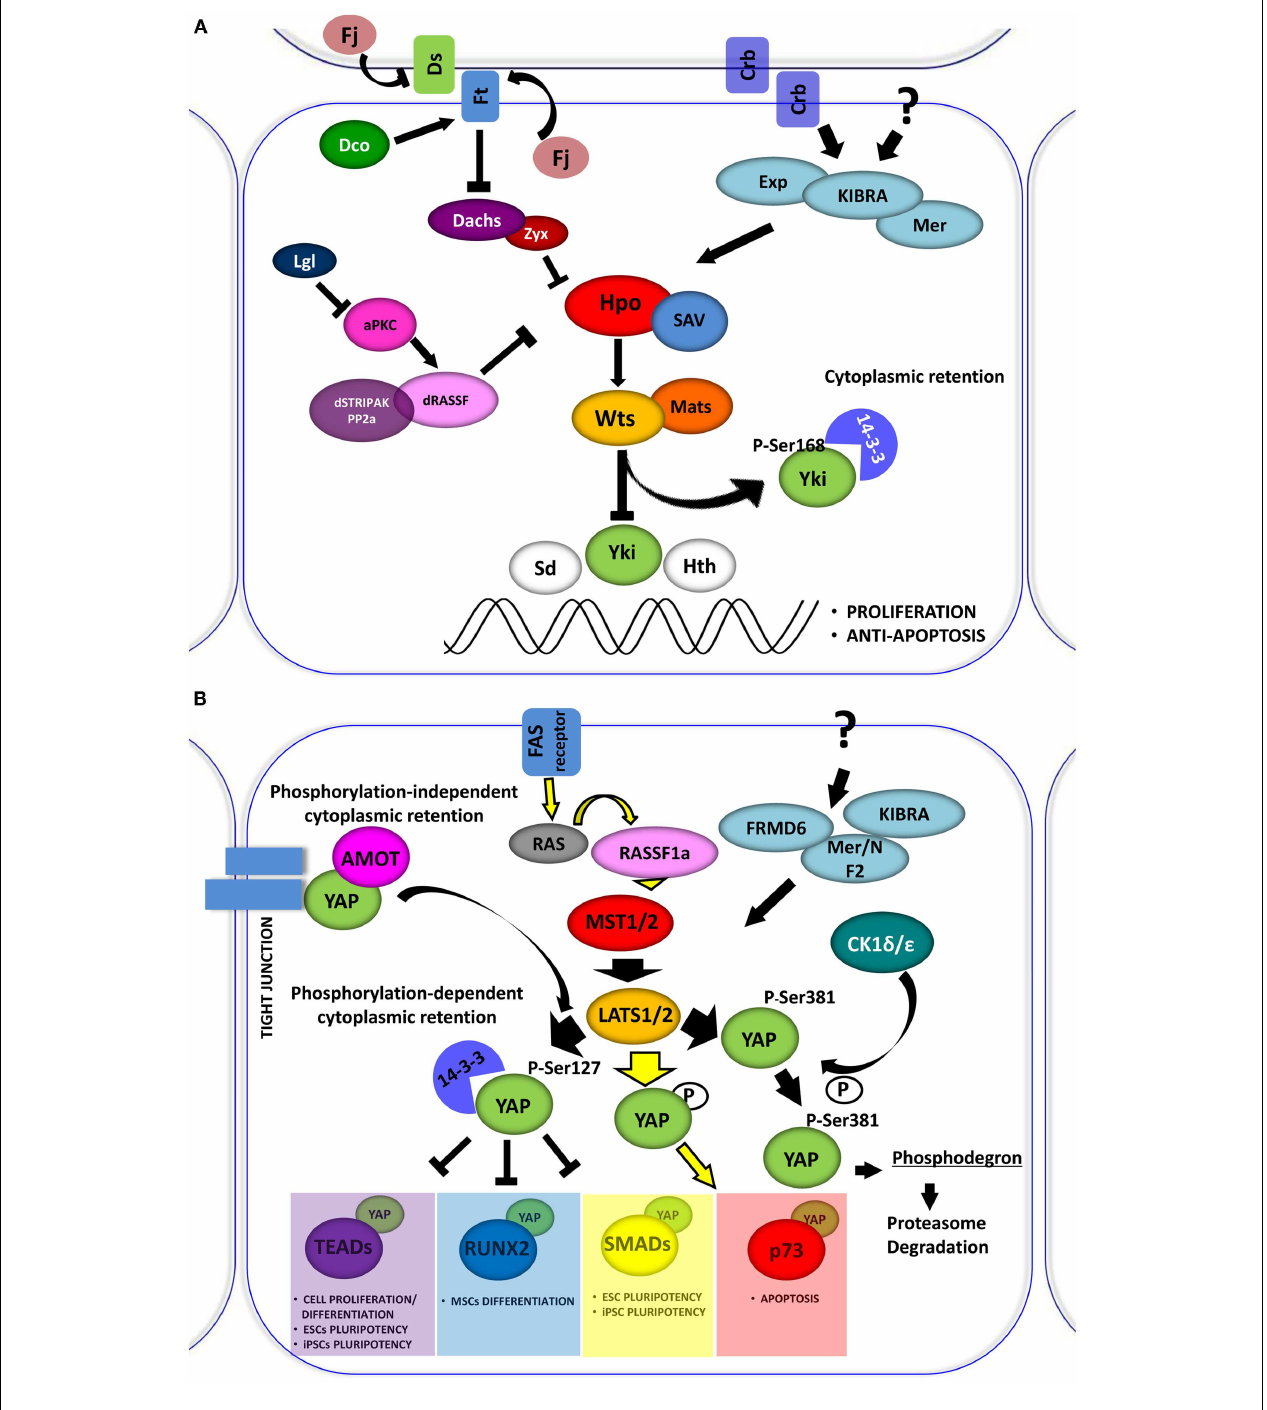
retention are conserved inYAP, which inhibits it to enhance the transcriptional activation of pro-proliferation genes. Depending on the cellular context Lats1/2 phosphorylatesYAP, increasing its transcriptional support to p73 to induce apoptosis.YAP can also be phosphorylated by other kinase, such as CDK1 δ / ε promoting its subsequent protein proteasome-degradation.The retention ofYAP at cytoplasmic level can also be exerted by sequestering the protein at the junctional level through the interaction with the AMOT